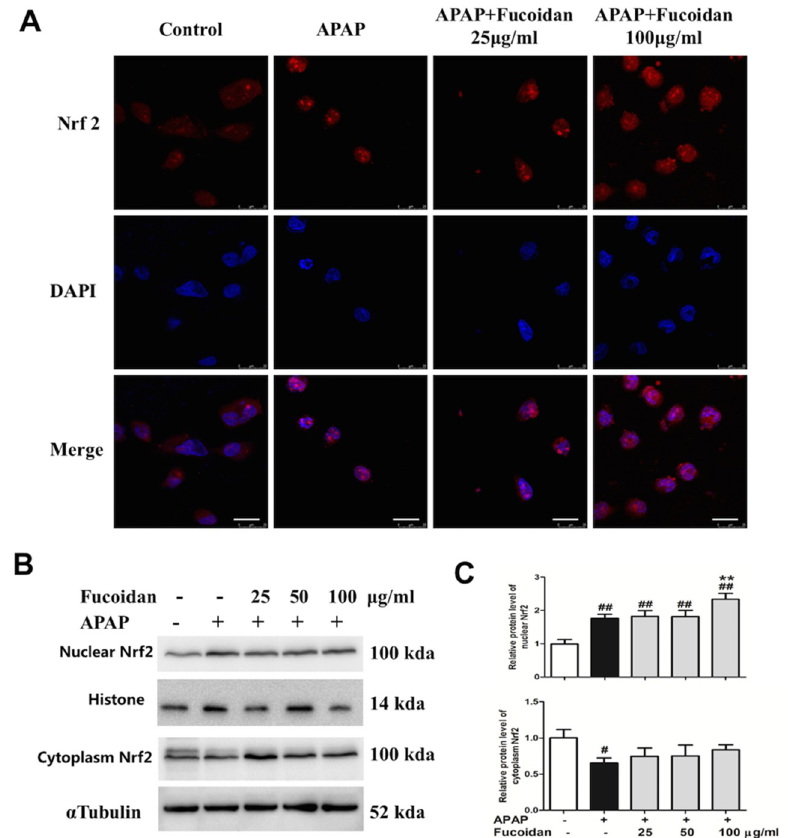
Figure 8. Effect of fucoidan on APAP-induced nuclear factor-erythroid 2-related factor 2 (Nrf2) expression and translocation in HL-7702 cells. Cells were treated with various concentrations of fucoidan (25, 50, or 100 µ g/ml) for 4 h, and were subsequently exposed to APAP (20 mM) for 24 h. ( A ) The effect of fucoidan on Nrf2 (red) translocation was tested by immunofluorescence staining and determined by a confocal microscope. The nuclei were stained with DAPI (blue) (Bar = 25 µ m). ( B , C ) Expression levels of nuclear Nrf2 and cytoplasm Nrf2 were determined by Western blotting analysis. Quantification of relative protein expression was performed by densitometric analysis, with histone and α Tubulin acting as controls. Similar results were obtained from three independent experiments. All results were expressed as mean ± SD, n = 3, ## p < 0.01 versus control group; ** p < 0.01 versus APAP-treated group.